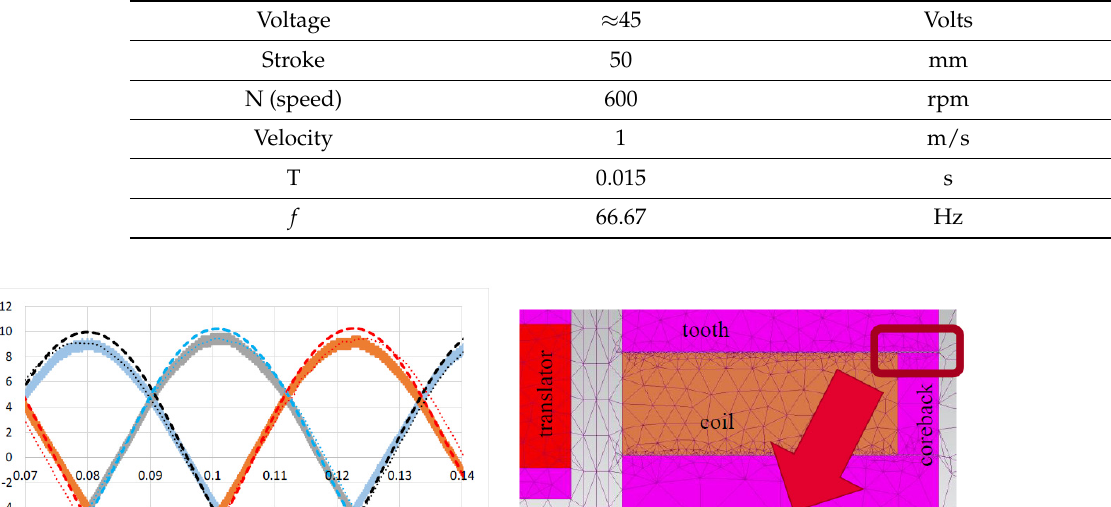
Figure 24. Back EMF at 600rpm with peak of ~ 1 m/s. Table 3. Parameters of back EMF tests.